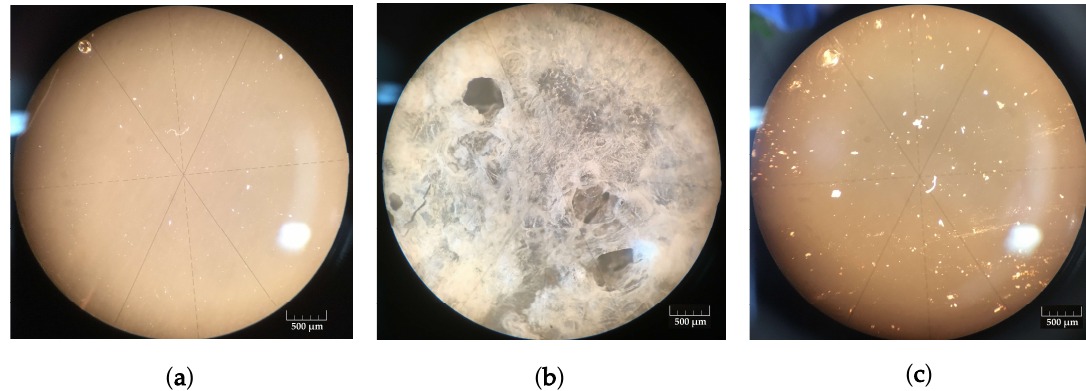
Figure 2. Optical images of ( a ) polyvinyl alcohol (PVA), ( b ) Na-salt of carboxymethylcellulose (Na-CMC), and ( c ) polyvinylpyrrolidone (PVP) dried films.